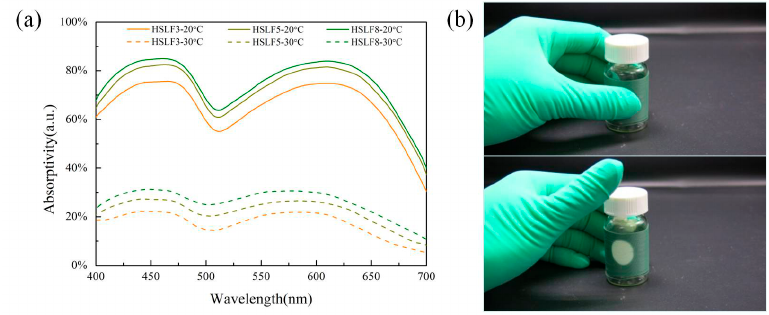
Figure 5. ( a ) Absorption spectra of HSLFs at 20 °C and 30 °C; ( b ) Thermochromicity of HSLF5 induced at body temperature.